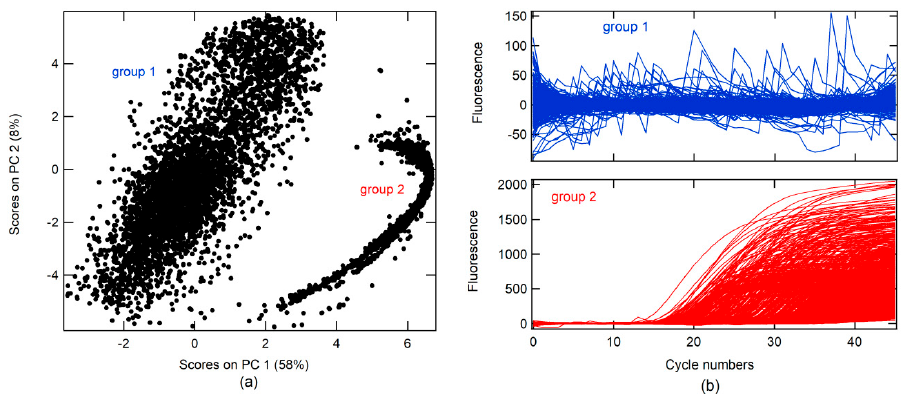
Figure 1. ( a ) Score plots of principal component (PC) 2 vs. PC 1 for real-time RT-PCR curves for SARS-CoV-2 diagnostics; ( b ) real-time RT-PCR curve plot for the two groups found during principal component analysis (PCA).